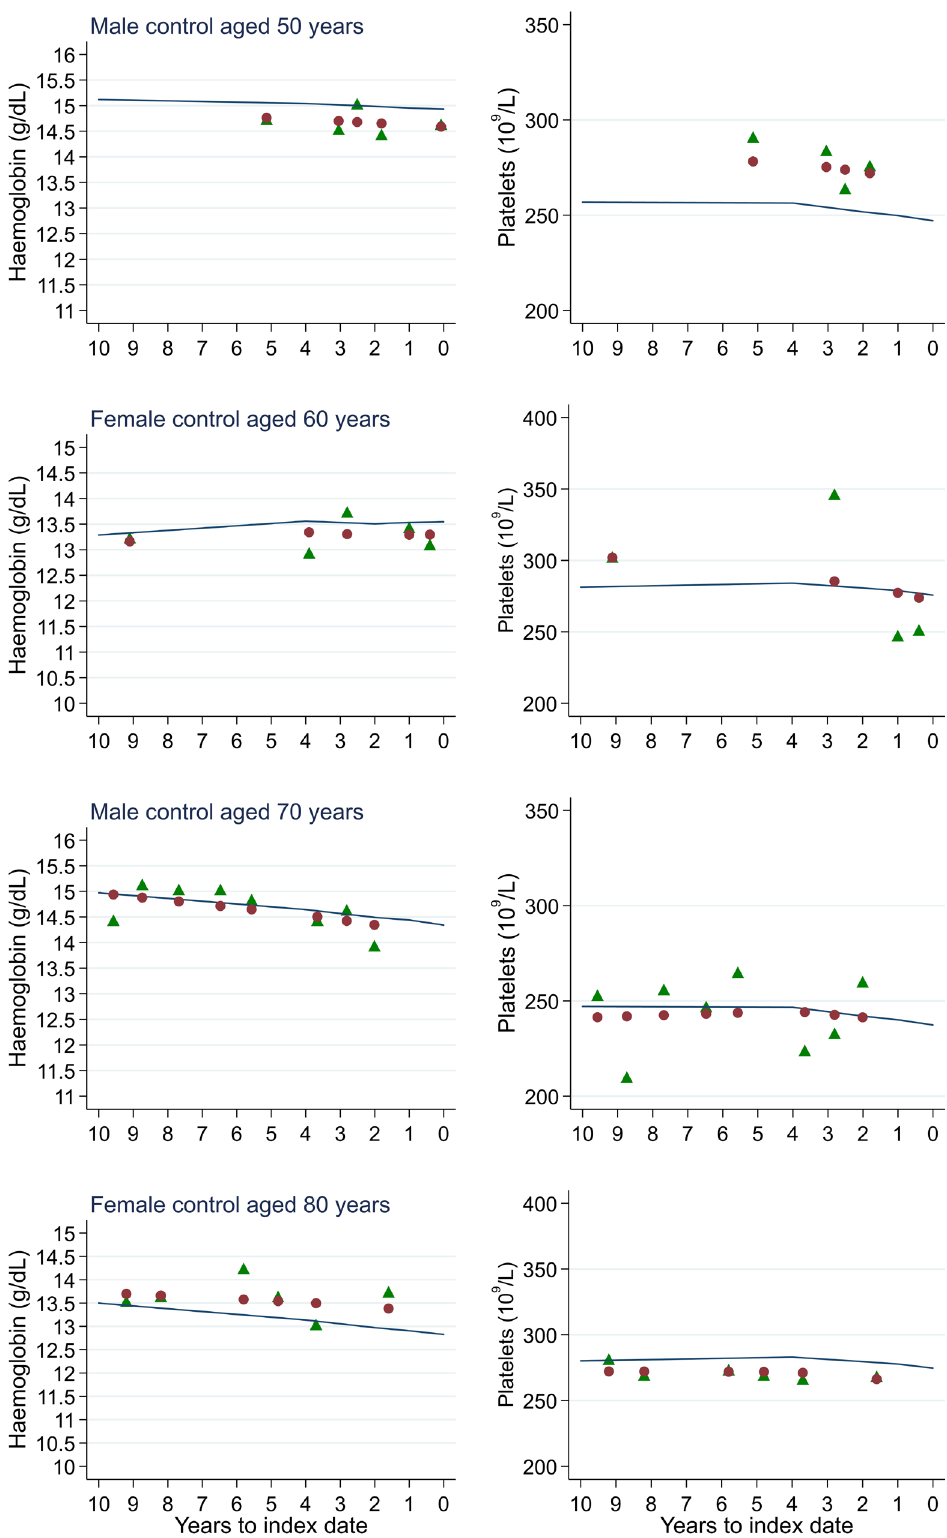
Figure 19. Individualised haemoglobin (left) and platelet (right) trends for four controls by age at index 1 . 1 Index date was the date of diagnosis for cases and a randomly selected date in the patient’s study period for controls. Legend: raw data (green triangle), modelled population-level trend (fixed effects) (blue line), modelled individualised patient-level trend (fixed and random effects) (red circle).